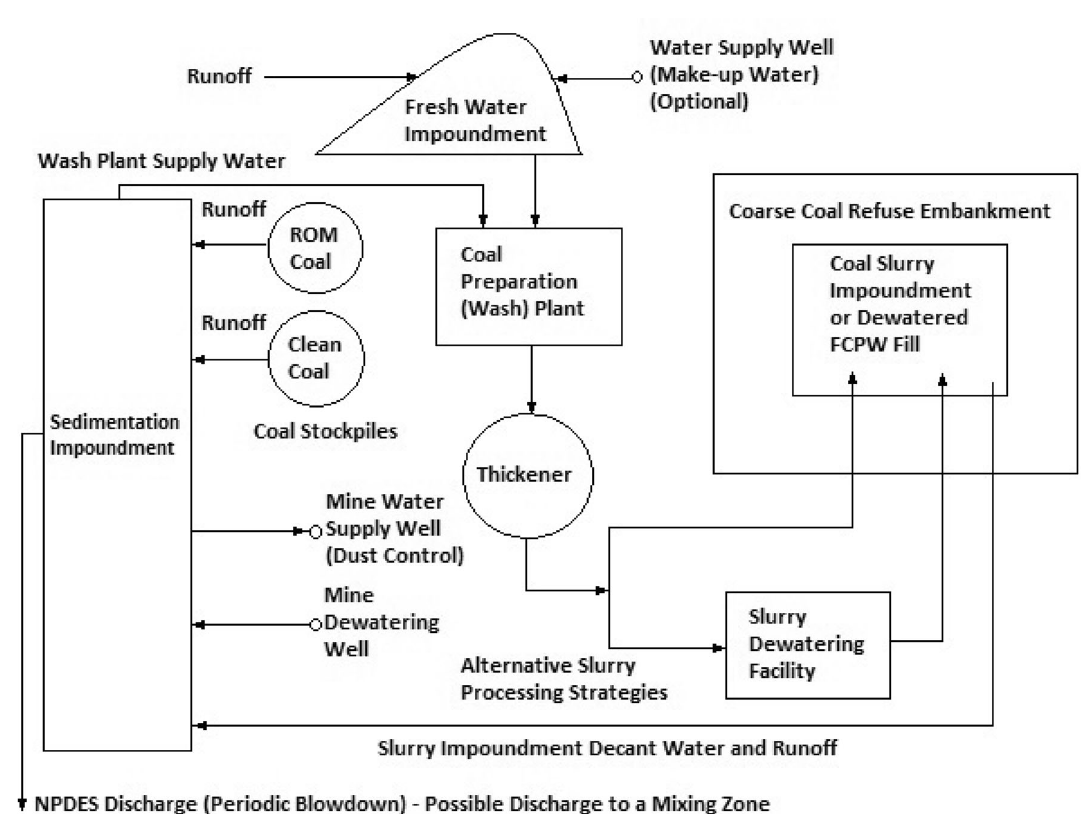
Fig. 1 Schematic of coal processing and water handling operations on the surface at a typical underground coal mine